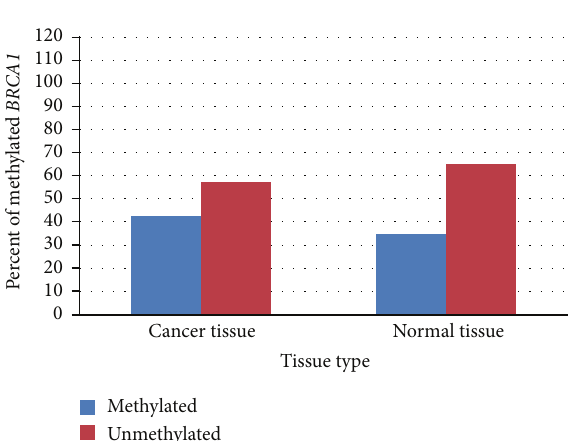
Figure 3: Difference between methylation status of BRCA1 pro- moter in cancer and normal tissue specimens.